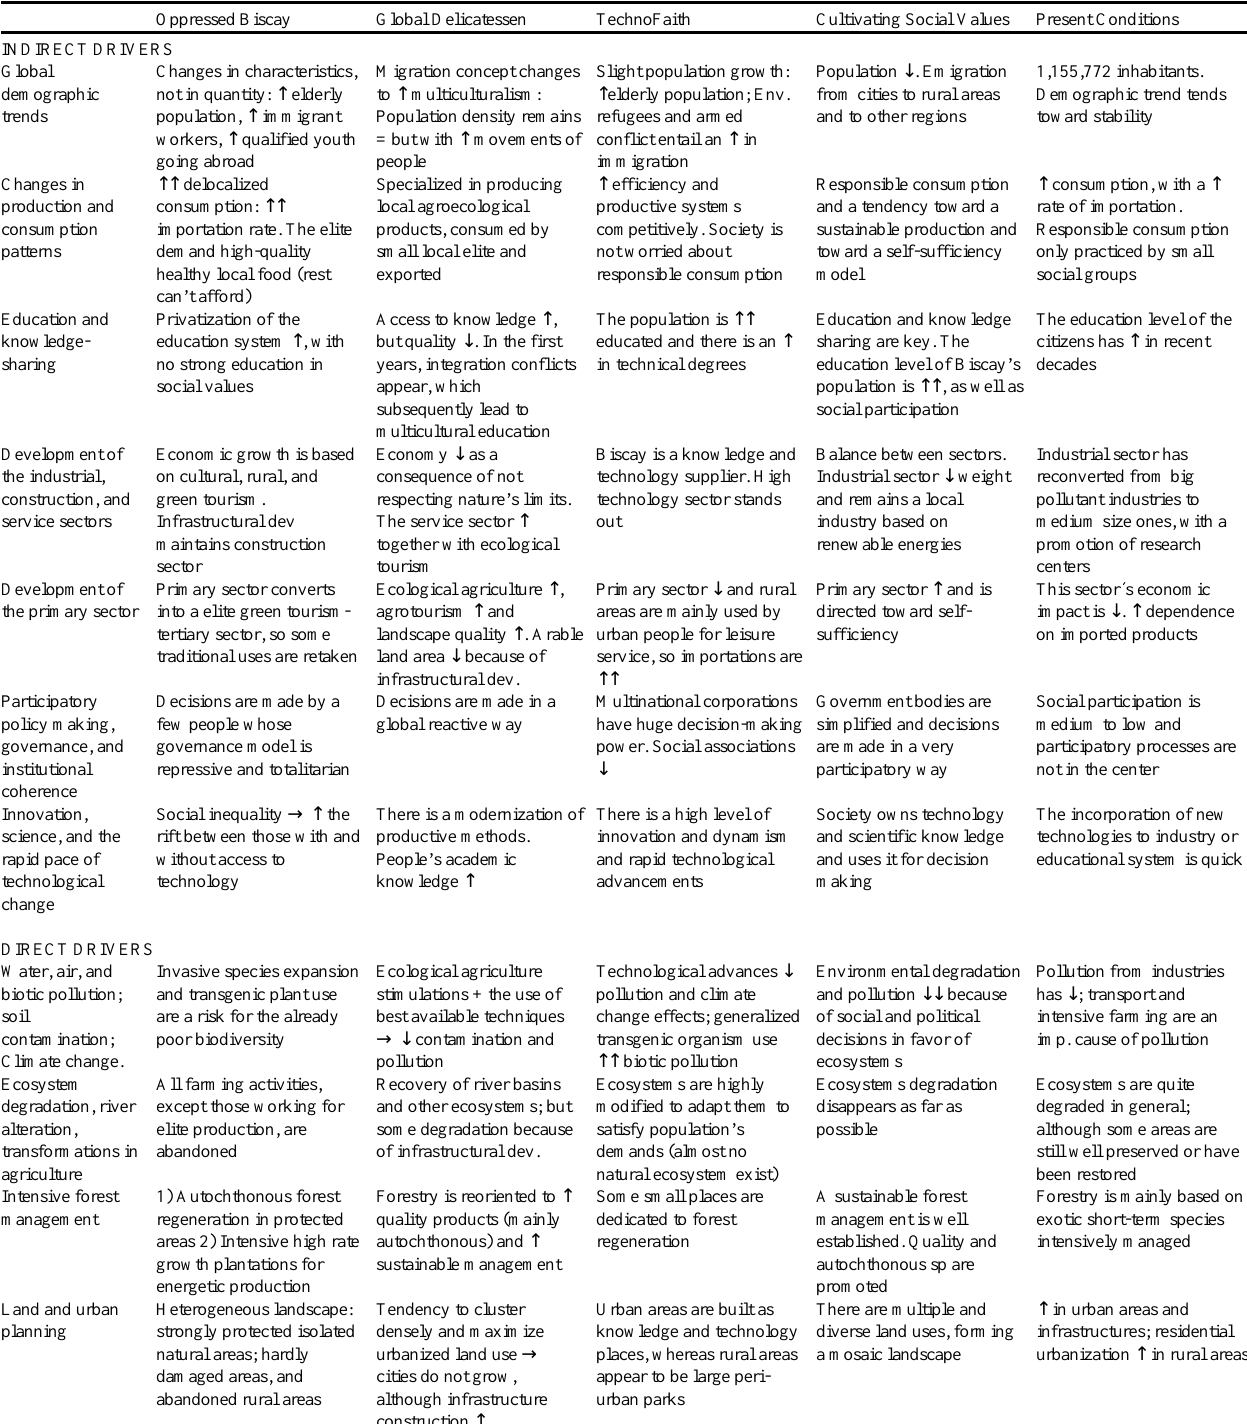
Table 1 . The main differences between scenarios in terms of the key indirect and direct drivers identified by participants. The final column describes the current conditions in the Biscay social-ecological system to compare the scenarios to current